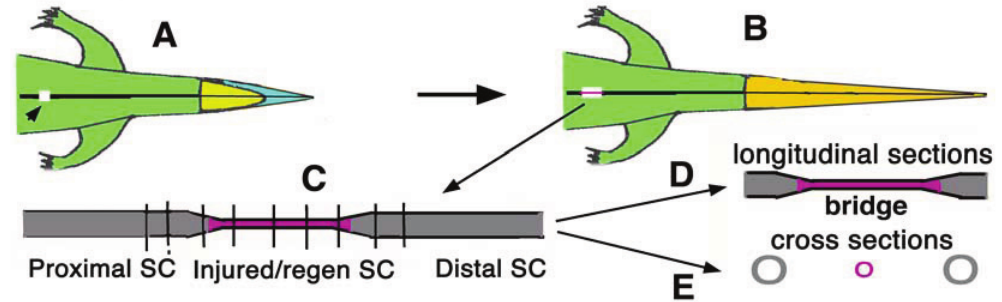
Figure 1. Schematic drawing showing the experiment presented in the study. The lumbar spinal cord was transected (arrowhead in A ) in lizard with regenerating tail ( B ). C shows the two stumps of the transected cord (grey color) and the thinner gap indicating the regenerated/repaired spinal cord (violet color). Both longitudinal ( D ) and progressive cross-sections ( E ) of the stumps spinal cord and of the repaired/regenerated gap were analyzed (see